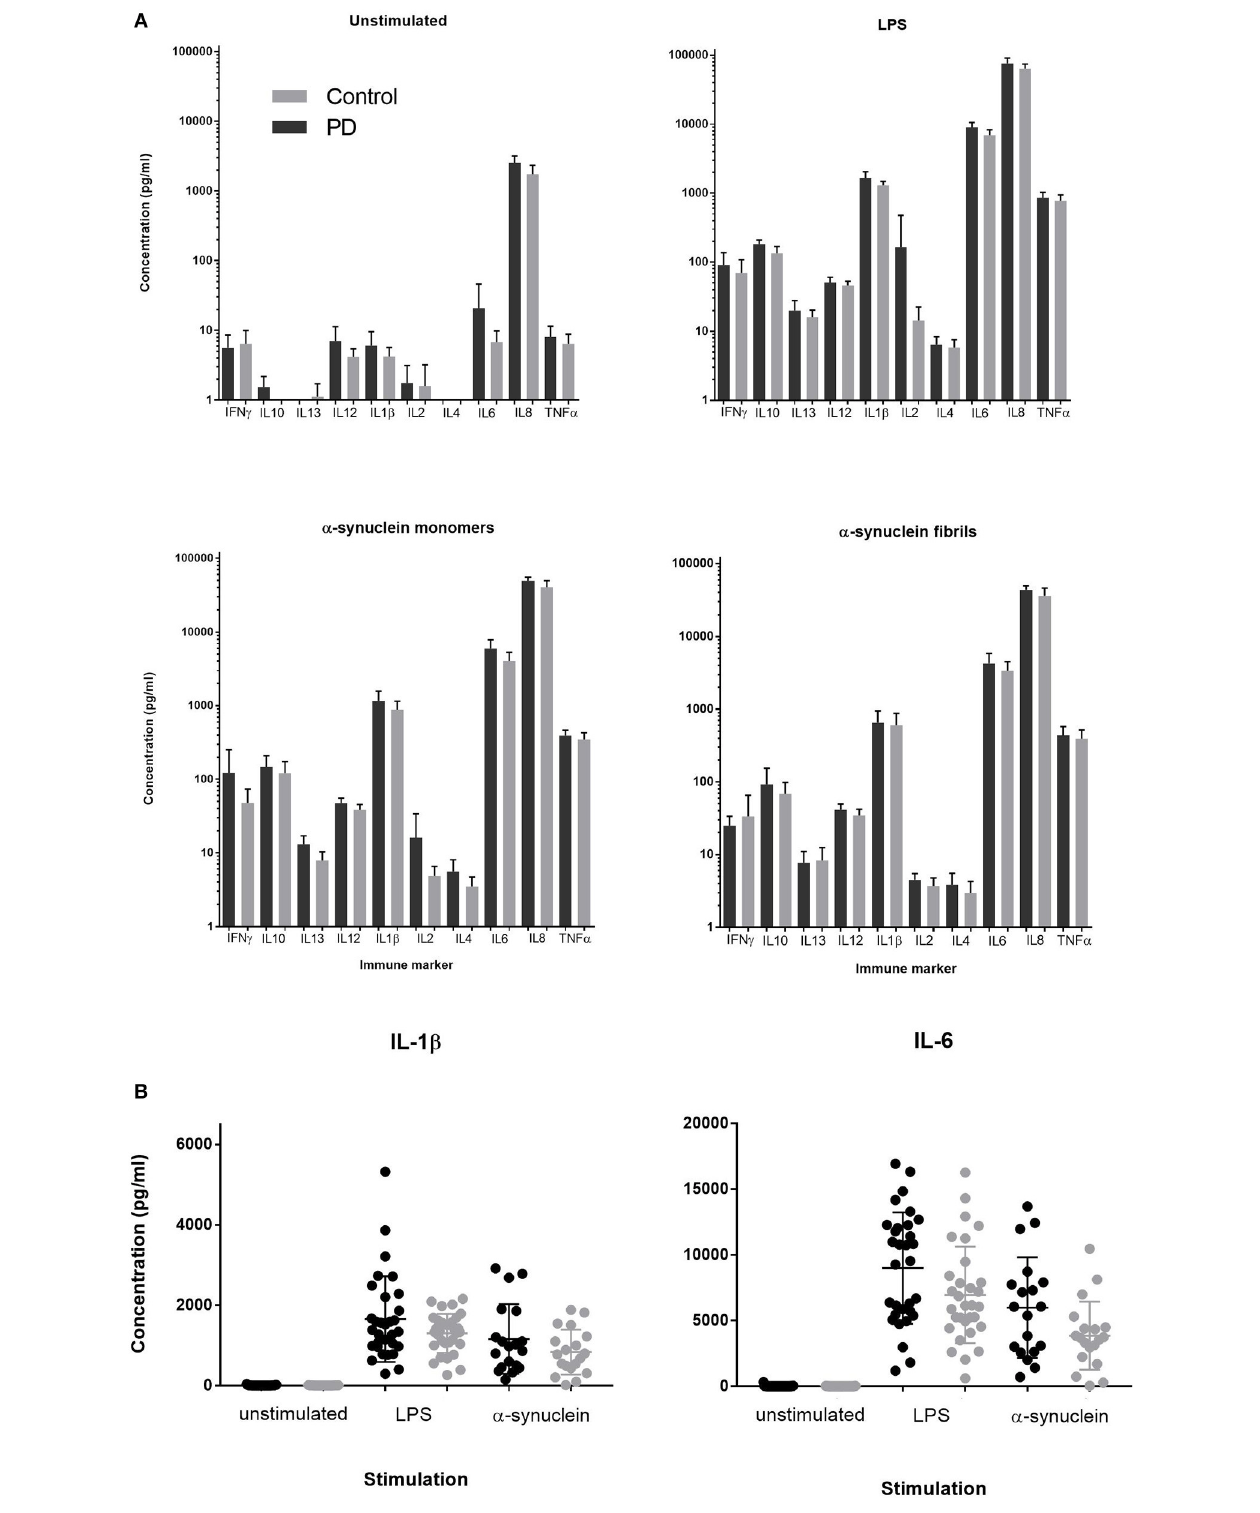
FIGURE 1 | (A) Supernatant cytokine concentration produced by PD and control PBMCs cultured for 24h in media containing LPS (1ng/ml), α -synuclein fibrils, or α -synuclein monomers (1 nmol = 27.3ng/ml). (B) Individual level data for IL-1 β and IL-6 concentrations in post-culture supernatant in PD cases and matched controls for direct comparison between unstimulated, LPS and α -synuclein monomer stimulation for two key inflammatory cytokines. Error bars represent SEM.